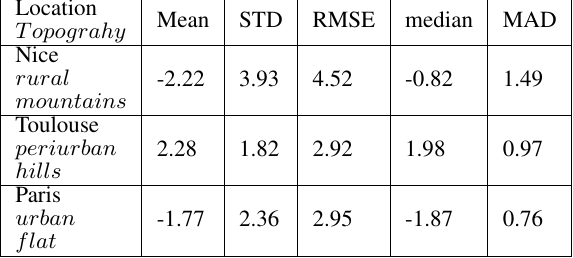
Table 2. Comparison between the DTM produced with Bullodzer and the IGN RGE alti ground truth.